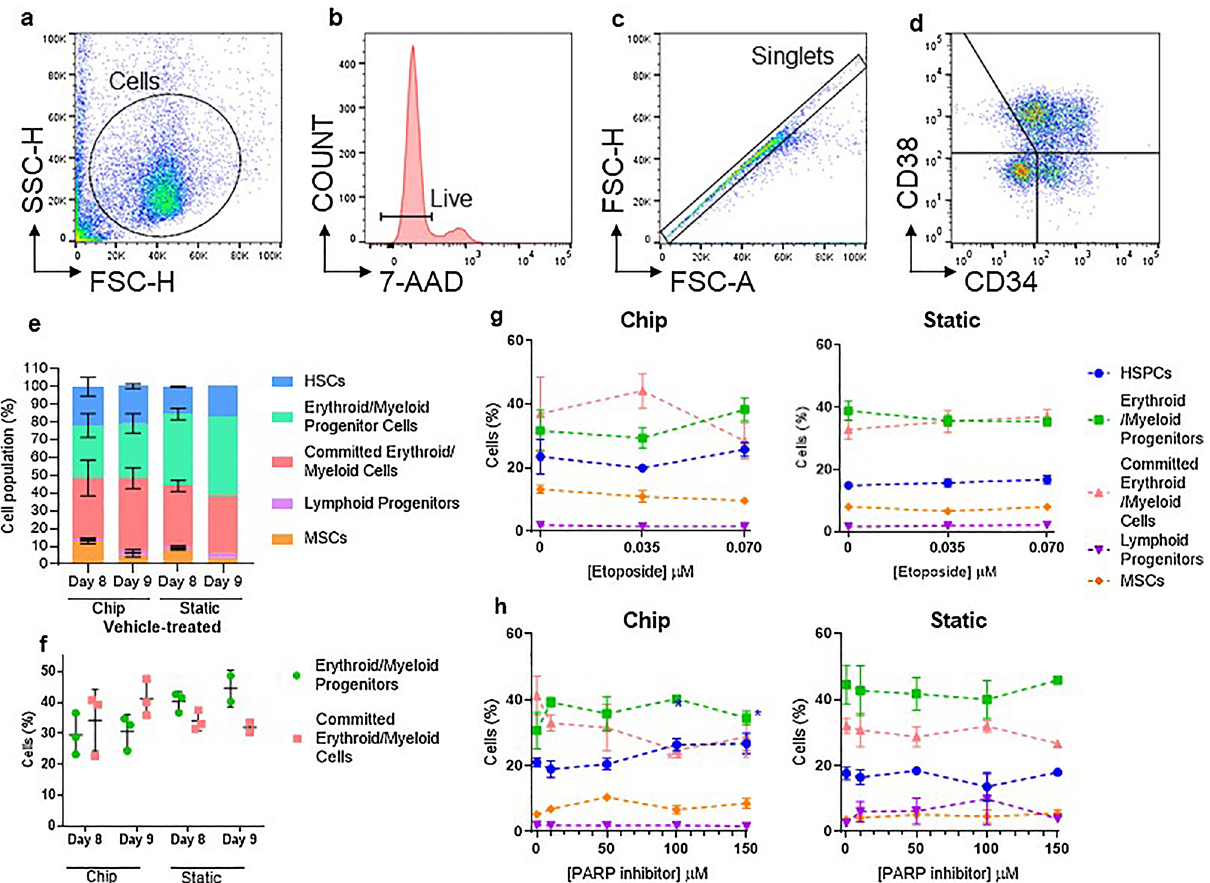
Figure 3. HSPCs within the 3D bone marrow models become differentiated into Erythroid/Myeloid cells, and the chip model drives differentiation further compared to the static. Harvested cells were characterised by flow cytometry using the markers CD34, CD38, CD73 and CD10. Example gating strategy ( a – d ) representative of all samples (doublet exclusion only performed on prednisolone-treated static model): CD34/CD38 gate on vehicle-treated controls, determined by FMO controls after 7-AAD viability dead cell exclusion; the percentages of HSPCs (CD34 + CD38 − ; blue); Erythroid/Myeloid Progenitors (CD34 + CD38 + ; green), Committed Erythroid/ Myeloid cells (CD34 − CD38 − and CD34 − CD38 + ; red); Lymphoid Progenitors (CD34 + CD38 − CD10 + and CD34 + CD38 + CD10 + ; purple) and MSCs (CD34 − CD73 + ; orange) following ( e – f ) vehicle-treatment (days 8